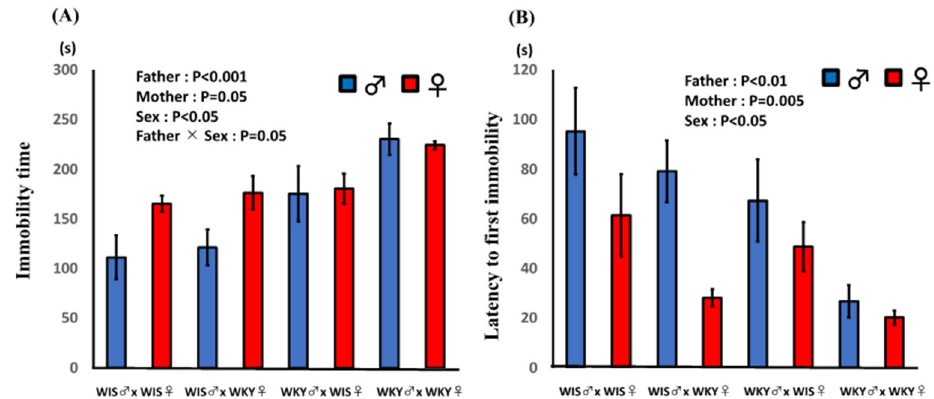
Figure 3. Effect of paternal or maternal strain and sex of pups on the results of the forced swimming test. ( A ) Immobility time and ( B ) latency to first immobility. Total immobility time and latency to first immobility were analyzed and are expressed as mean ±SEM. Here, NS = not significant. Pups were 60–61 days old; WIS ♂ × WKY ♀ refers to pups of male Wistar (WIS) and female Wistar Kyoto (WKY) rats ( n = 6).